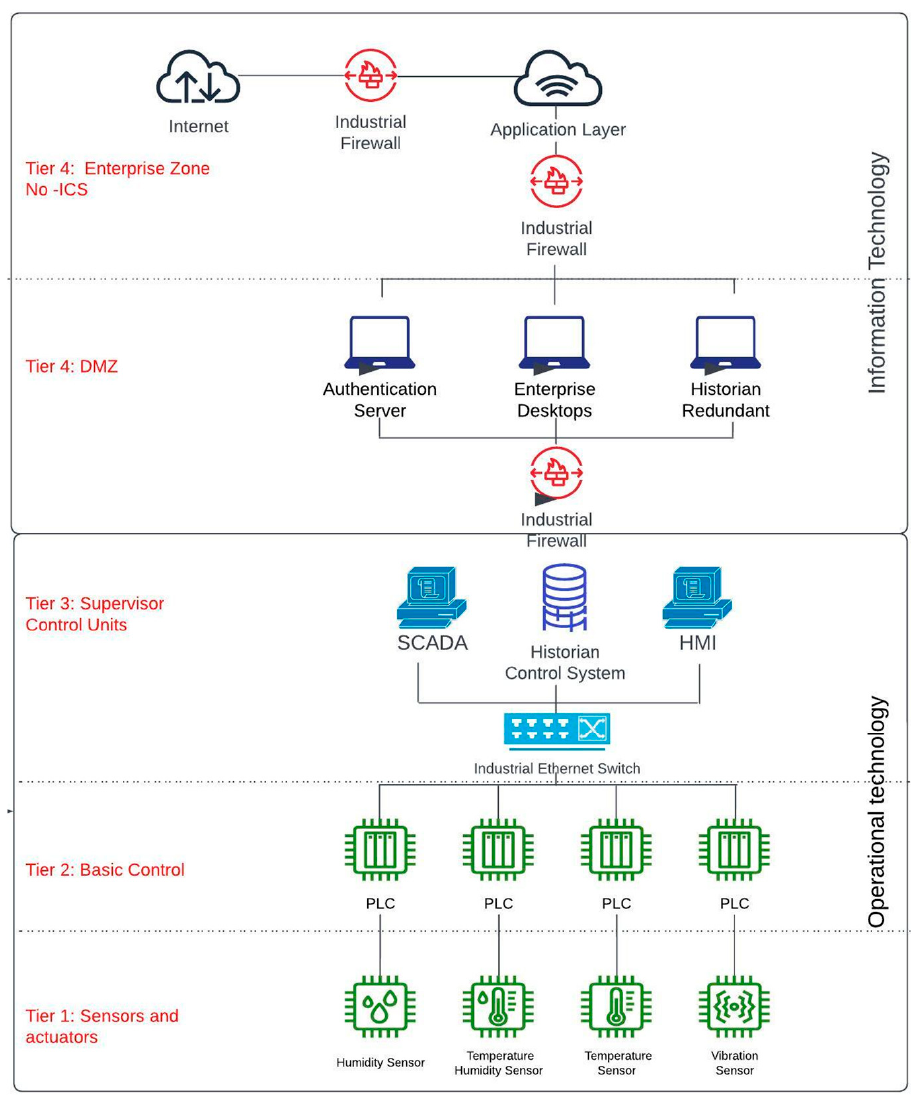
Figure 1. ICSs Architecture based on the Purdue Model.